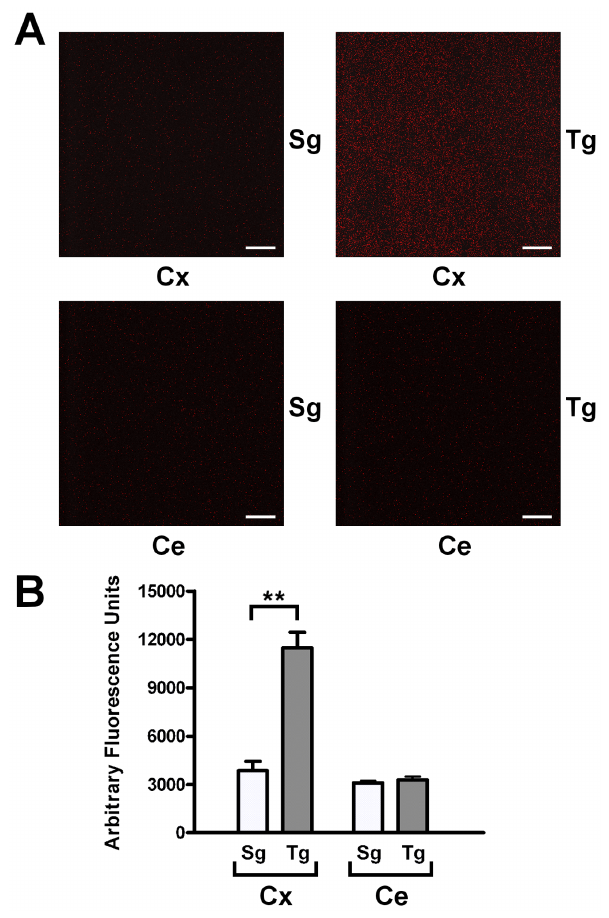
Figure 5. In situ detection of H 2 O 2 in mouse neocortex and cerebellum. A. Mouse neocortex and cerebellum from Tg and Sg were stained with AUR reagent and analyzed by LSCM (HeNe laser emitting at wavelength of 543 nm). B. Quantification of stained H 2 O 2 molecules. The p values were measured with the one-way ANOVA test and post- hoc test Bonferroni (**, p , 0.01). Sg, syngenic mice; Tg, transgenic mice; Cx, cortex; Ce, cerebellum.